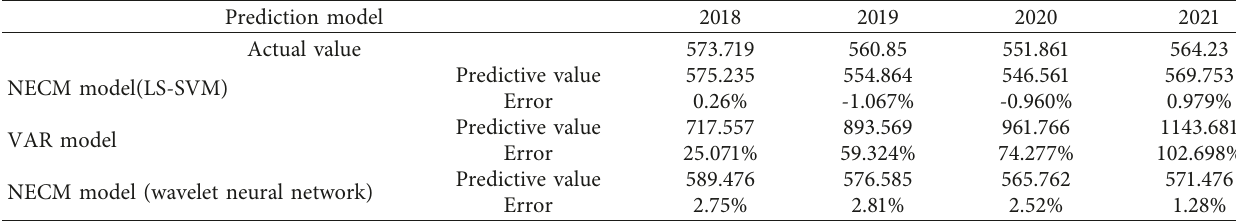
Table 7: SMPI prediction results and errors 2000 �